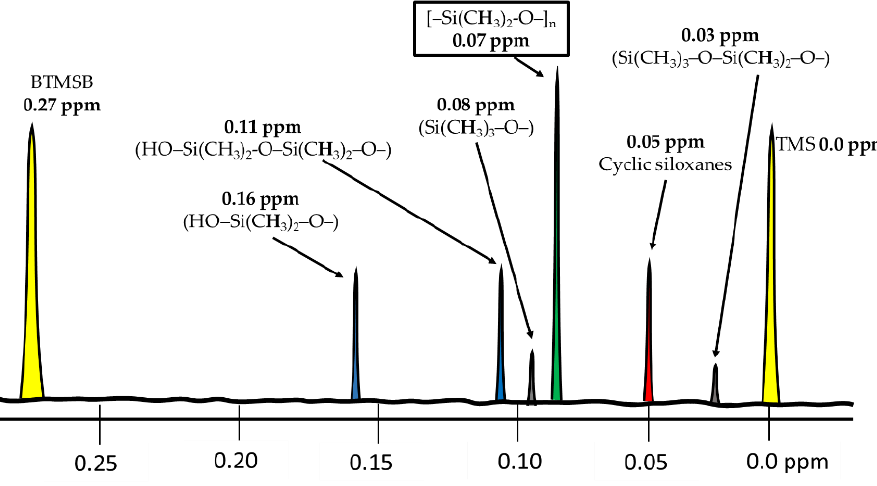
Figure 3. 1 H-NMR chemical shifts of different PDMS moieties and reference substances.